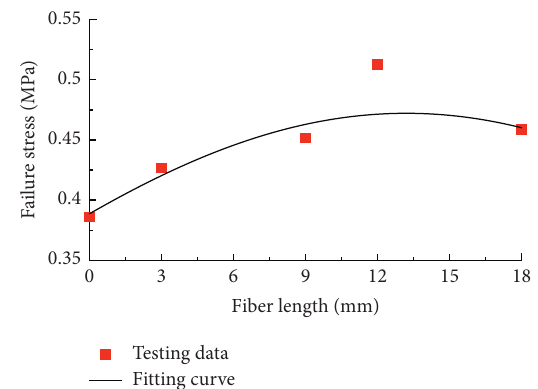
Figure 11: Deviatoric strength envelopes for fiber-reinforced soil with different fiber length (confining pressure � 0.1 MPa; com- paction degree � 100; fiber content � 0.2%).